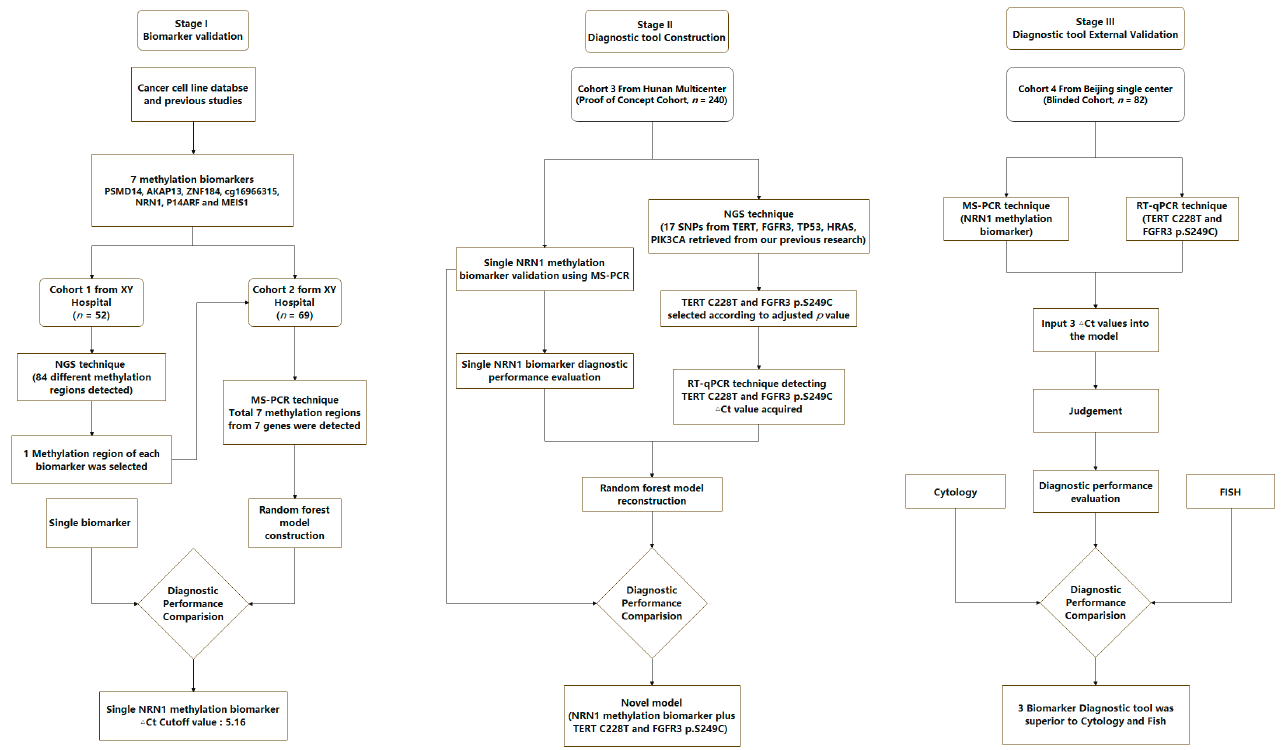
Figure 1. Flow chart of the study design.